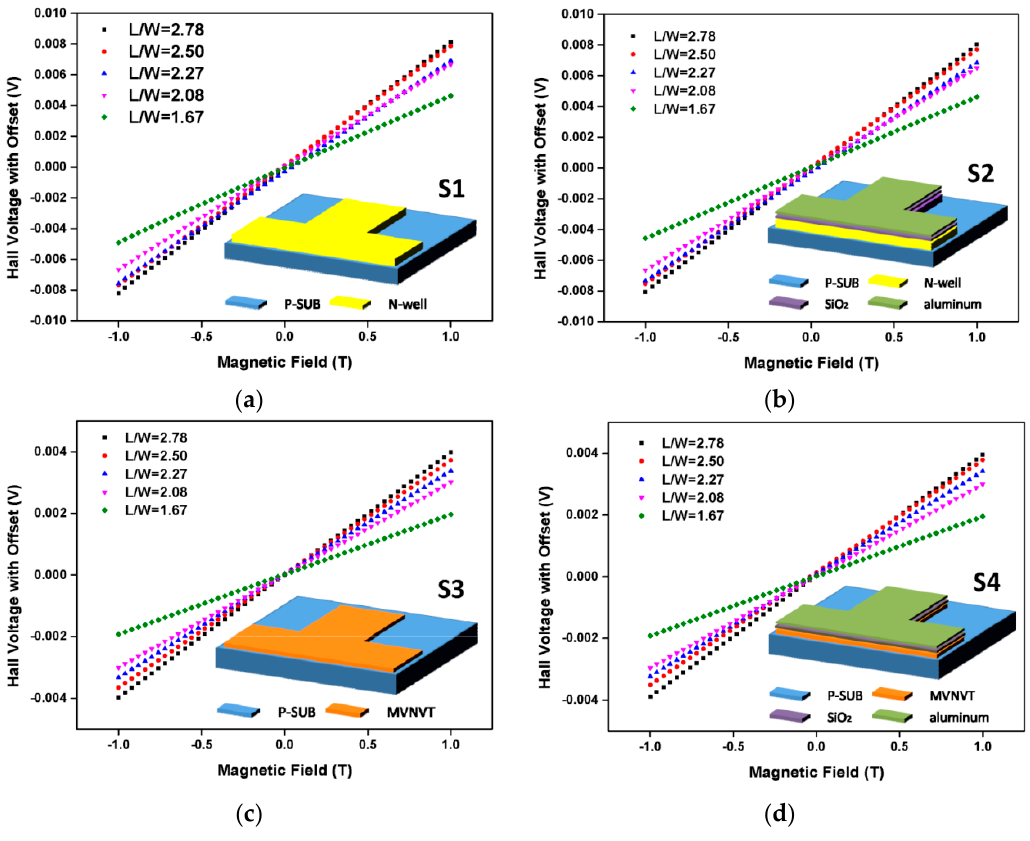
Figure 4. The measured Hall voltage (coupled with offset) as a function of applied magnetic field for S1 ( a ), S2 ( b ), S3 ( c ), S4 ( d ) with different L/W ratios.